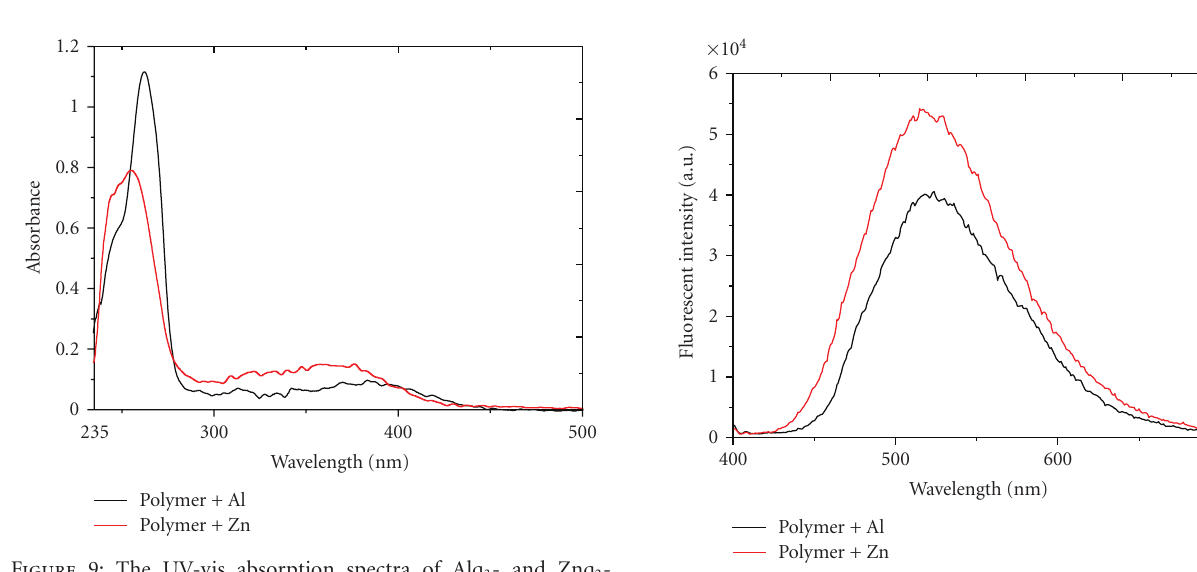
Figure 10: The fluorescence spectra of Alq 3 - and Znq 2 -containing copolymers in CHCl 3 . The concentration of 8-hydroxyquinoline moieties is 2.0 × 10 − 5 M and excitation wavelength is 380